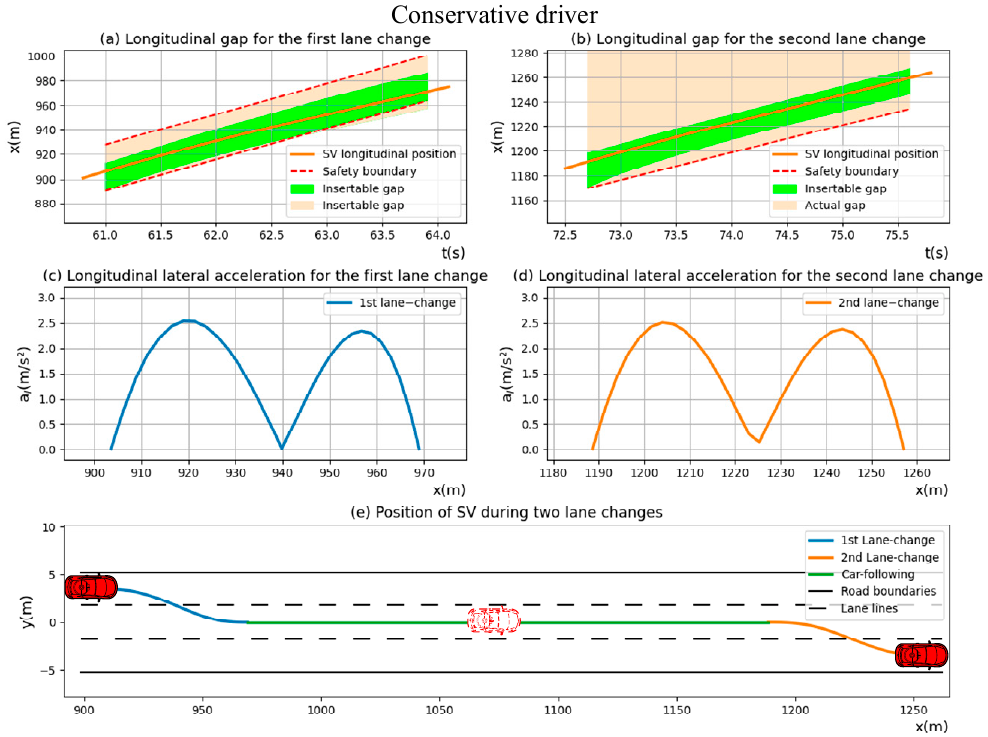
Figure 6. The position, lateral acceleration and trajectories of “Conservative driver” during two lane-changing processes.